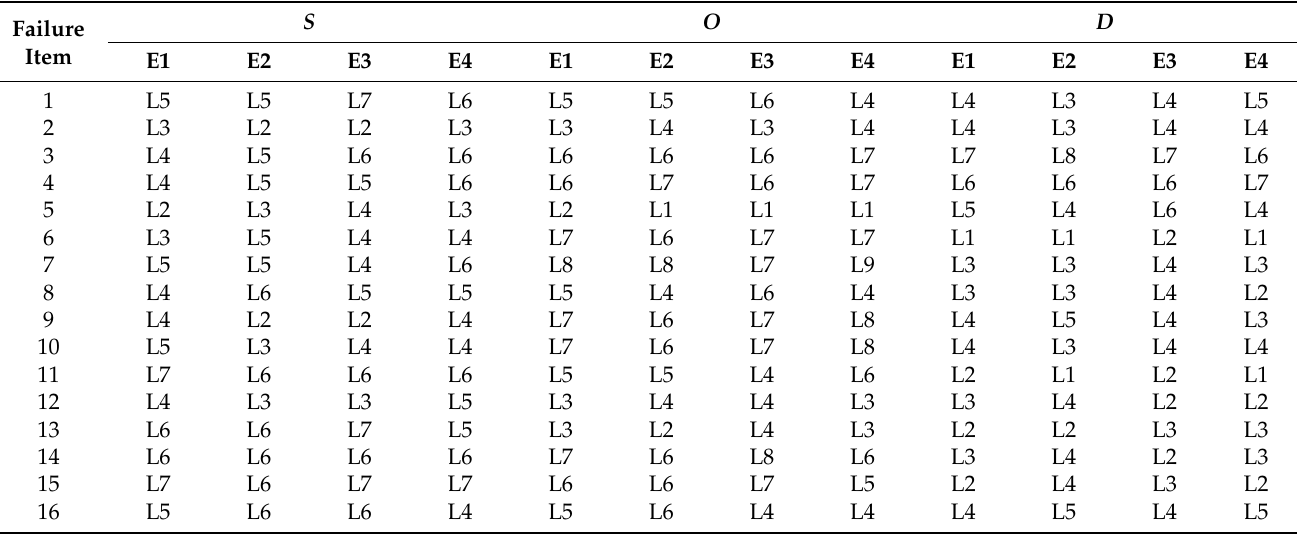
Table 4. The linguistic terms of possible failure items.